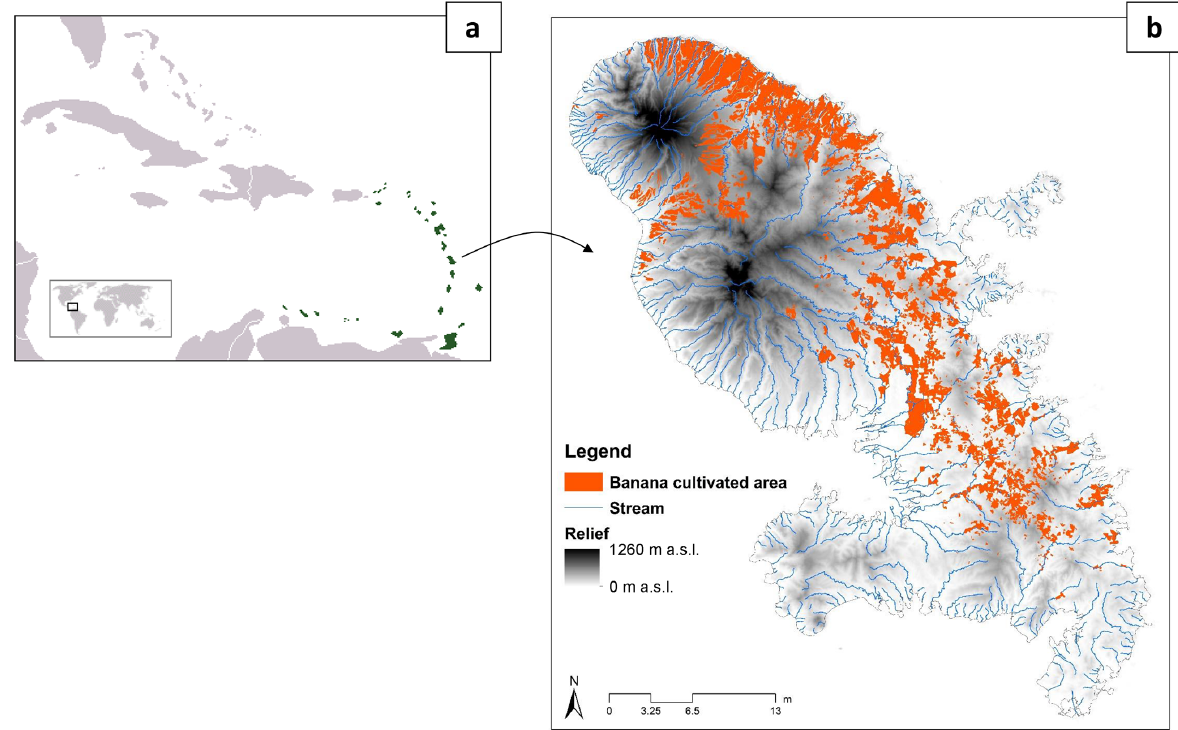
Figure 1. Location (a) and relief (b) of the island of Martinique (FWI) in the Caribbean showing the banana cultivated